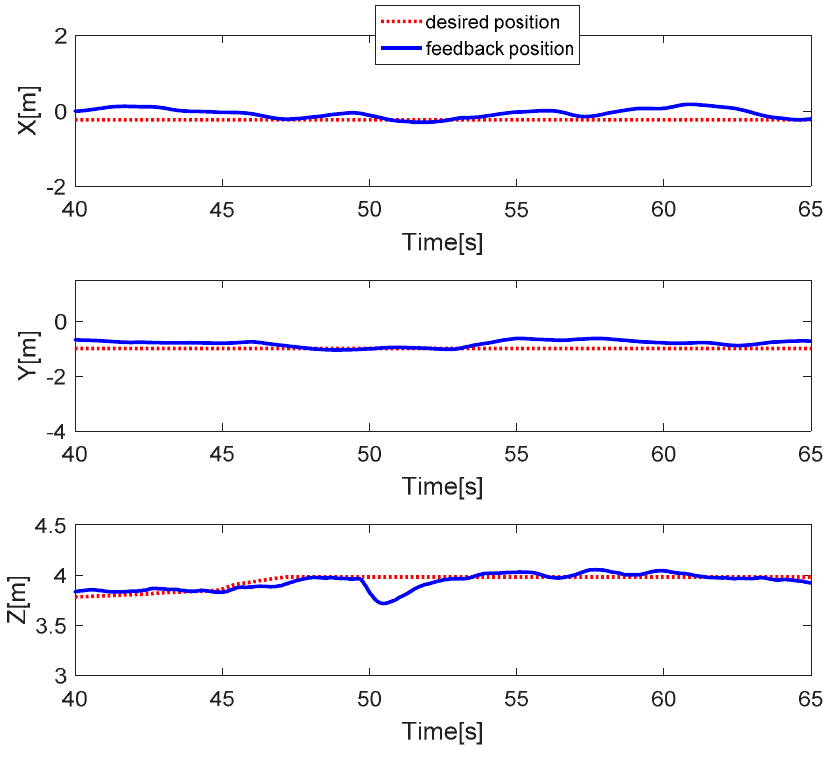
Figure 15. Horizontal and vertical movement.